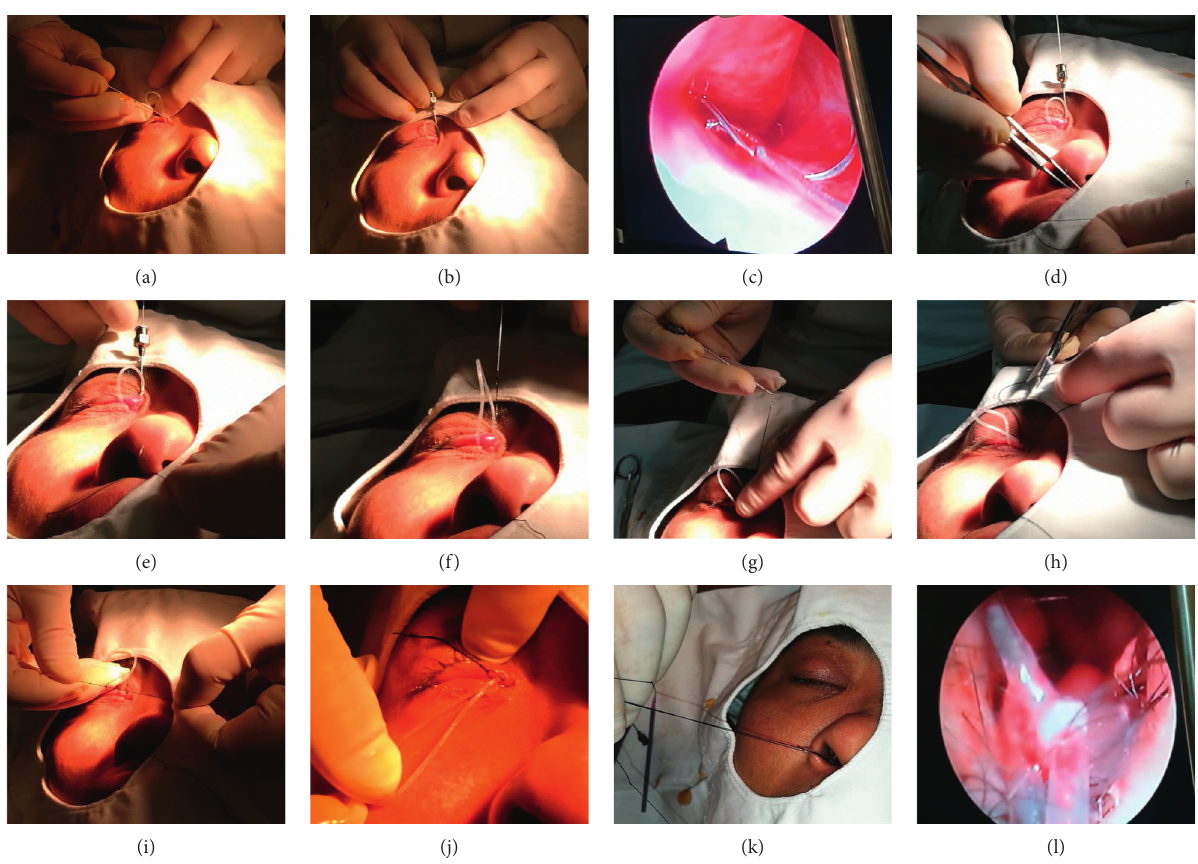
Figure 3: The surgical maneuvers for repositioning the silicone tube. (a) A memory wire probe is gently introduced through the punctum and passed down the nasolacrimal duct to the nasal cavity. (b) The probe is rotated to place carved number “9” face up. The tail of the memory wire is gently pushed, making its head out through the probe. (c) A video endoscope is put into the nasal cavity to ensure that the probe is not coming out of any false passages, hooking out the memory wire. (d) and (e) A 5-0 nylon suture is threaded through the memory wire’s head. (f) The memory wire is withdrawn into the probe. Then, the probe is pulled, together with the nylon suture, through the lacrimal passage retrograde until it is out of the punctum. (g) The probe and the memory wire are removed. (h) The 5-0 nylon suture is cut into two lines from the middle. (i) One line of the nylon is coiled to the silicone tube and tied to another line. (j) This turns into a “lasso” to capture the silicone tube. (k) Gentle traction is kept on the distal end of the nylon suture, and the “lasso” slides down from the punctum to the dacryocyst around the silicone tube, pulling the silicone tube into its proper position. (l) Nasal endoscope shows the reposition of the silicone tube and its